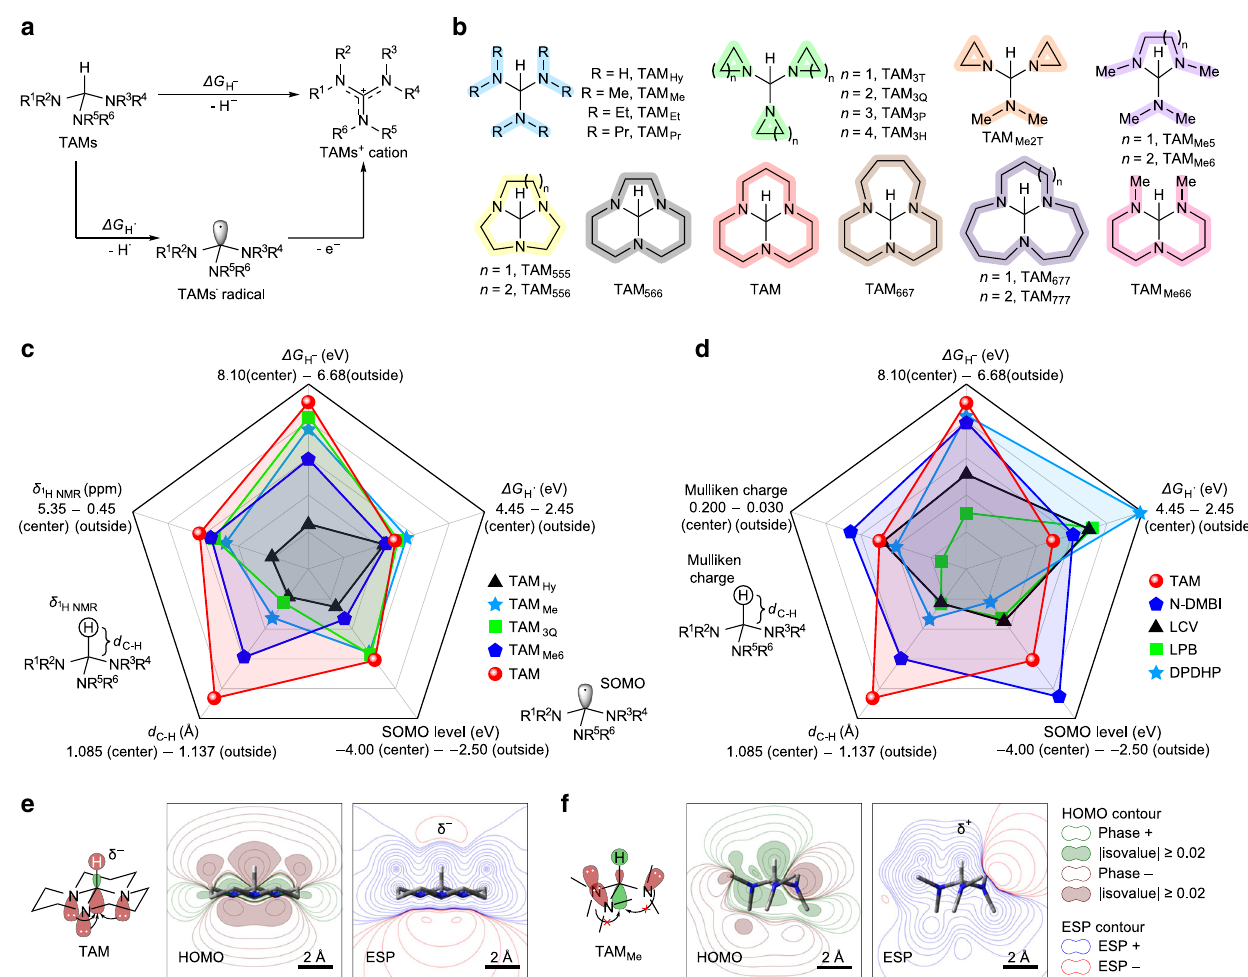
Fig. 1 Dopant design and n -doping ability prediction. a Design of triaminomethanes (TAMs) dopants with their guanidine-type cations. b Chemical structures of some designed TAMs. c , d Radar charms for predicting n -doping ability of TAMs ( c ) reported hydride dopants ( d ). Evaluating indexes includes density functional theory (DFT) calculated Gibbs free energy change in hydride-transfer half-reaction ( Δ G H − ) and hydrogen-atom transfer half- reaction ( Δ G H (cid:129) ), singly occupied molecular orbital (SOMO) level of dopant radical, charge distribution (Mulliken charge or 1 H-NMR chemical shift) of reactive hydrogen, and hydrogen-carbon bond length ( d C – H ). e , f Secondary orbital interactions, highest occupied molecular orbital (HOMO) and electrostatic potential (ESP) contours of TAM and TAM Me . DFT calculations performed under B3LYP/6-311 + G(d,p) level. TAM and other TAMs with 1,5,7-triazabicyclo[4.4.0]decane backbone (TAM 566 , TAM 667 , and TAM Me66 ) show the highest predicted n -doping ability among